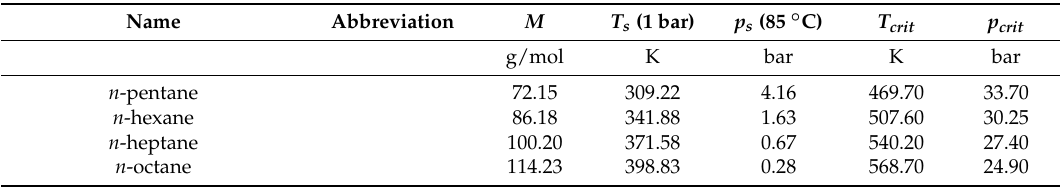
Table A1. Molar mass M , saturation temperature T s at 1 bar, saturation pressure p s at 85 ◦ C, critical temperature T crit and pressure p crit for evaluated working